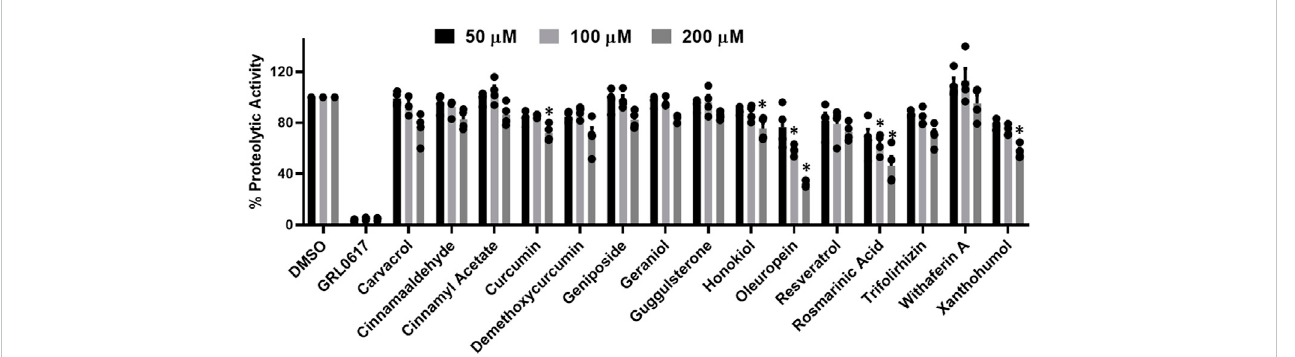
FIGURE 3 InhibitionofproteolyticactivityofSARS-CoV-2PLproenzymebyselectedmiscellaneousphytochemicals.Miscellaneousphytochemicalswereselected and screened for their inhibitory activity against the SARS-CoV-2 PLpro enzyme as described under Materials and Methods. The fl uorescence intensity was used to calculate the percent proteolytic activity considering DMSO treated control as 100% activity. Blank values were subtracted before calculating the percent activity. Representatives of four individual experiments (n = 4) with triplicate values were presented graphically and analyzed using GraphPad Prism 8. p -values < .05 considered as statistically signi fi cant compared to the DMSO control.